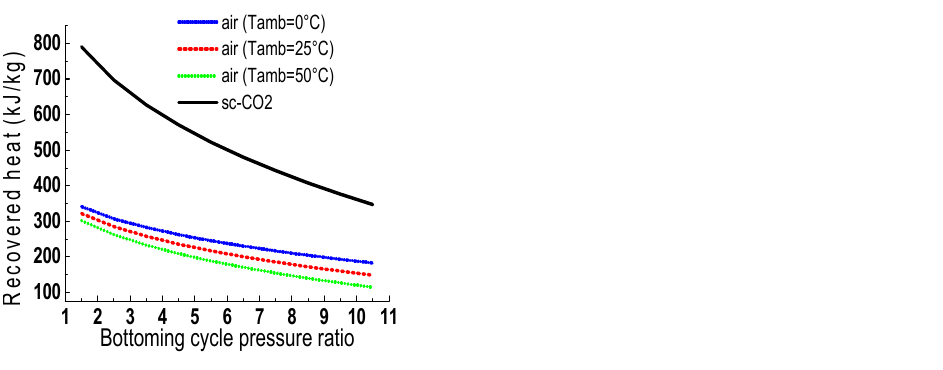
Figure 7. Recovered heat versus bottoming cycle pressure ratio with air at different ambient temperatures and with sc-CO 2 .